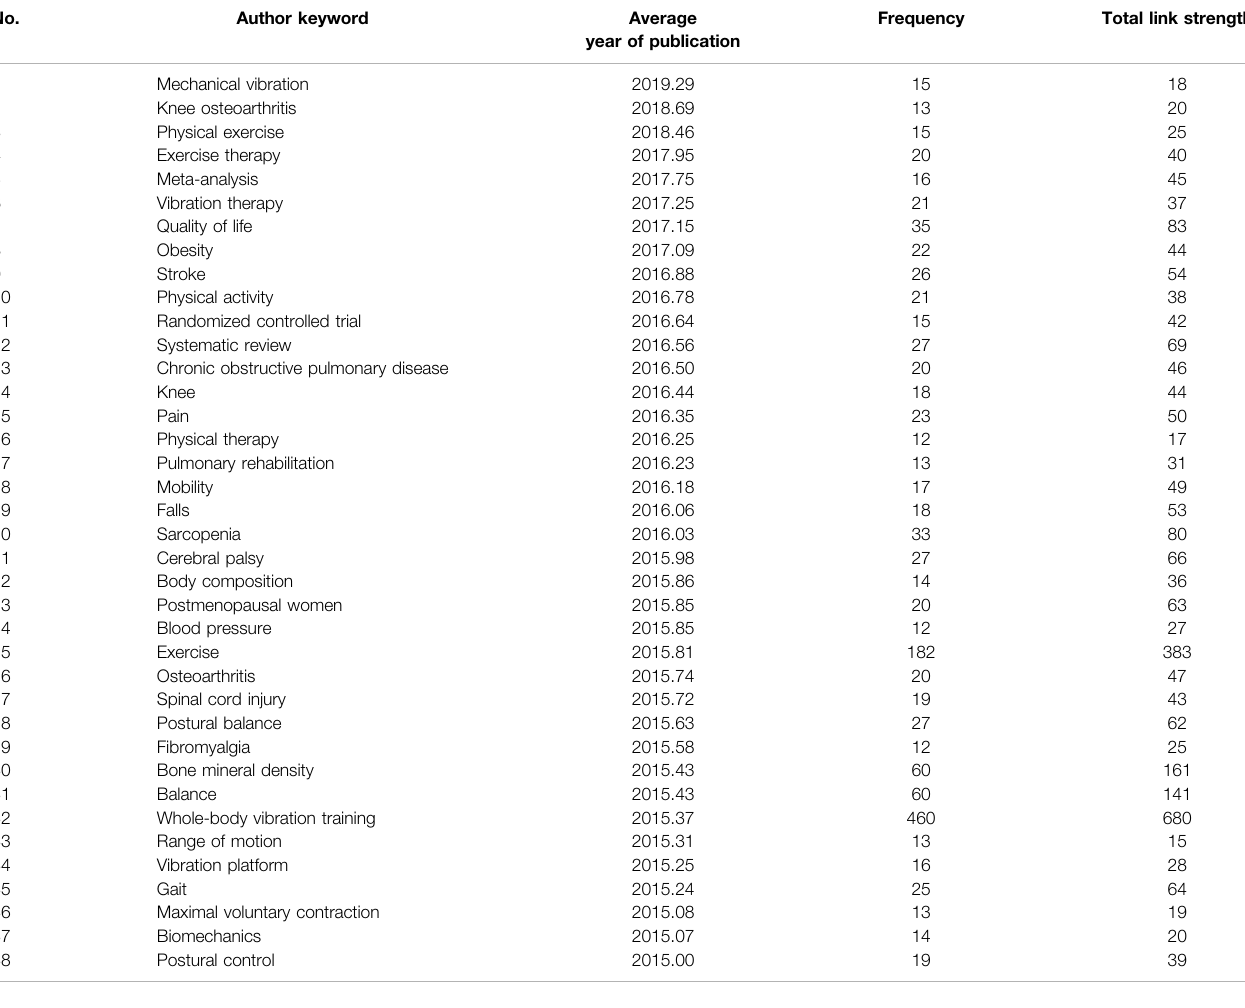
TABLE 7 | Keywords appearing after 2015 in the WBVT study.